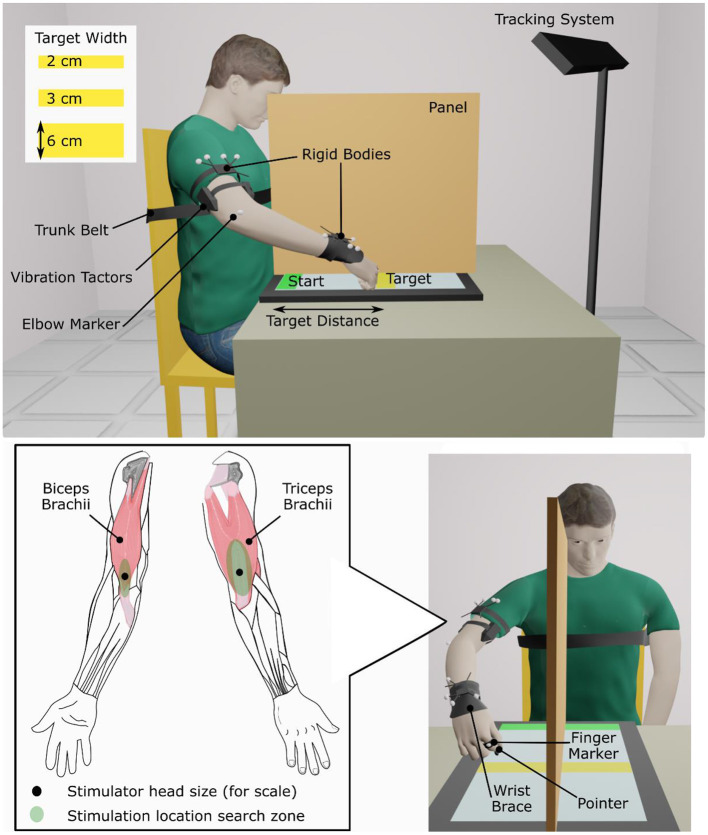
Experimental setup.